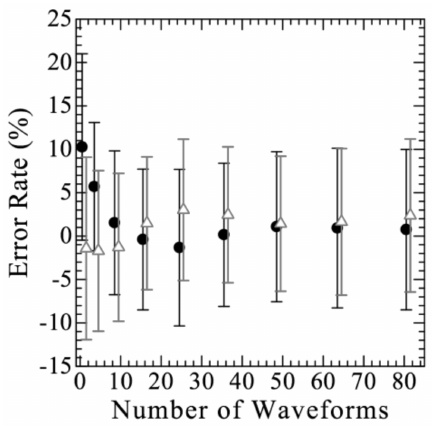
Figure A1. Variations in the error rate of the electric field distribution, obtained by changing the num- ber of waveforms analyzed. The circles and triangles represent the results obtained for waveforms under the V L and V H conditions, respectively. The error bar represents their standard deviation. Plots were horizontally shifted to increase